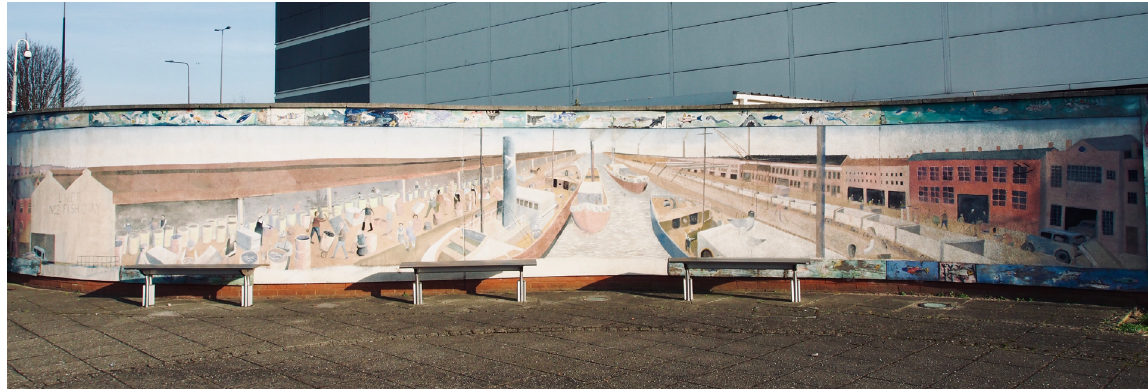
Mural in St Andrew’s Retail Park referencing the site’s past, original photo by author,